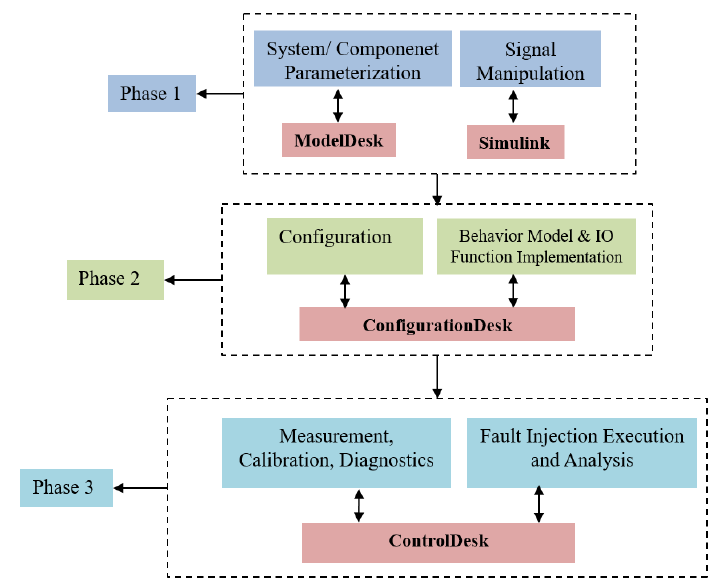
Figure 7. Scheme of the complete HiL simulation system.